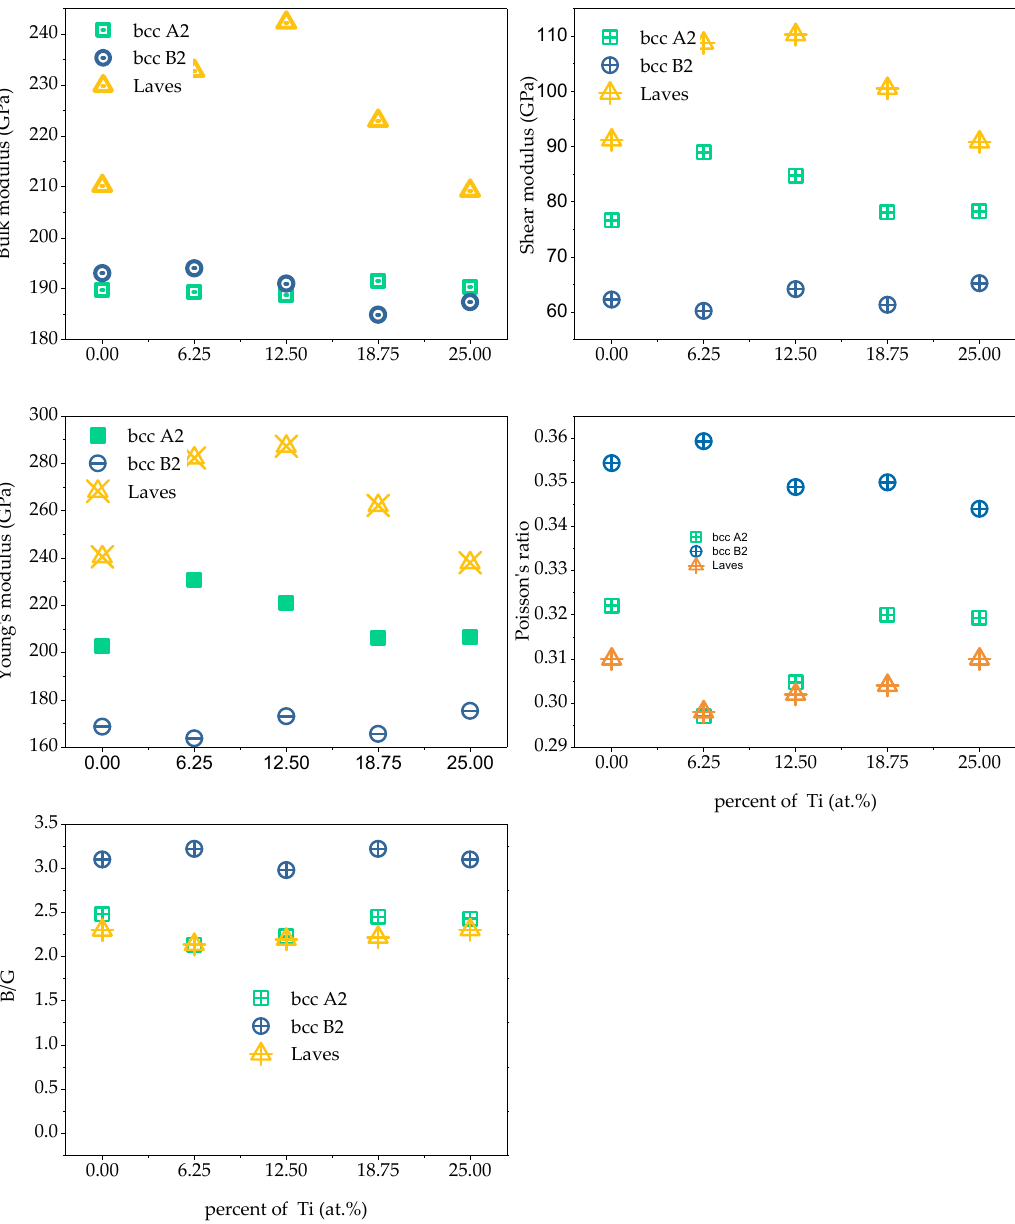
Figure 14. The calculated average properties (bulk modulus (B), shear modulus (G), elastic modulus (E), and Poisson’s ratio ( ν )) for single-phase Fe 25 Cr 25 Ni 25 Ti x Al (25 − x) of different atom occupancy positions by using Voigt–Reuss–Hill approximation.